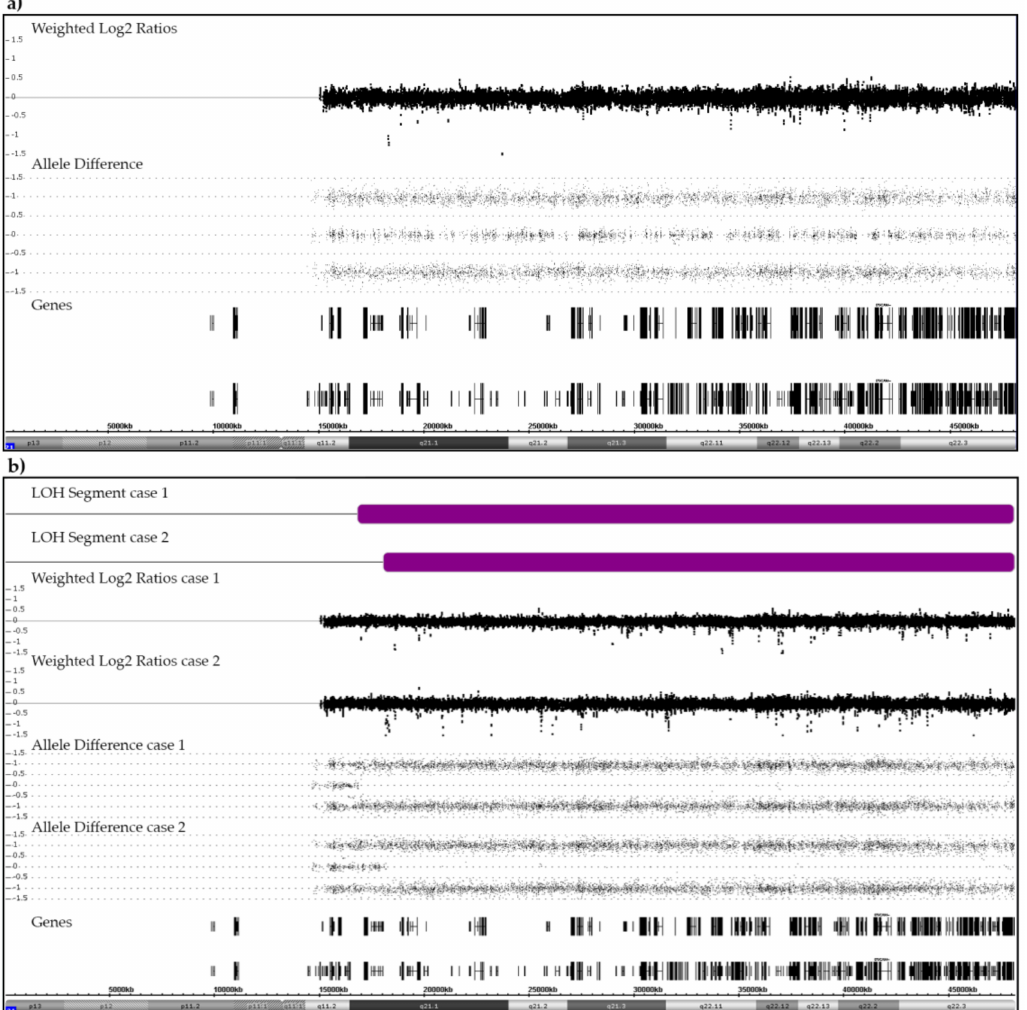
Figure 1. Examples of SNP/CGH array patterns that were obtained from a case with a normal heterozygous ( a ) and from two cases with a partially homozygous pair of chromosomes 21 ( b ). ( a ) The allele distribution pattern of a normal pair of heterozygous chromosomes 21 serves as reference point for the interpretation of any deviant allele distribution patterns discussed herein. The weighted log2 ratios and the SNP allele pattern are shown in the middle part. Black vertical and horizontal bars in the bottom part indicate the location of genes on chromosome 21. ( b ) Two cases with a CN-LOH (purple bars). In case 1, the size of the CN-LOH is 31.3 Mb (21q21.1q22.3; chr21:16,818,166–48,084,820). The recombination took place between the NRIP1 and USP25 genes (chr21:16,437,126–17,102,253). In case 2, the size of the CN-LOH is 30 Mb (21q21.1q22.3; chr21:18,031,461–48,084,820). The recombination took place between the MIR99AHG (NR_136542) and LINC01549 (NR_037585) genes (chr21: